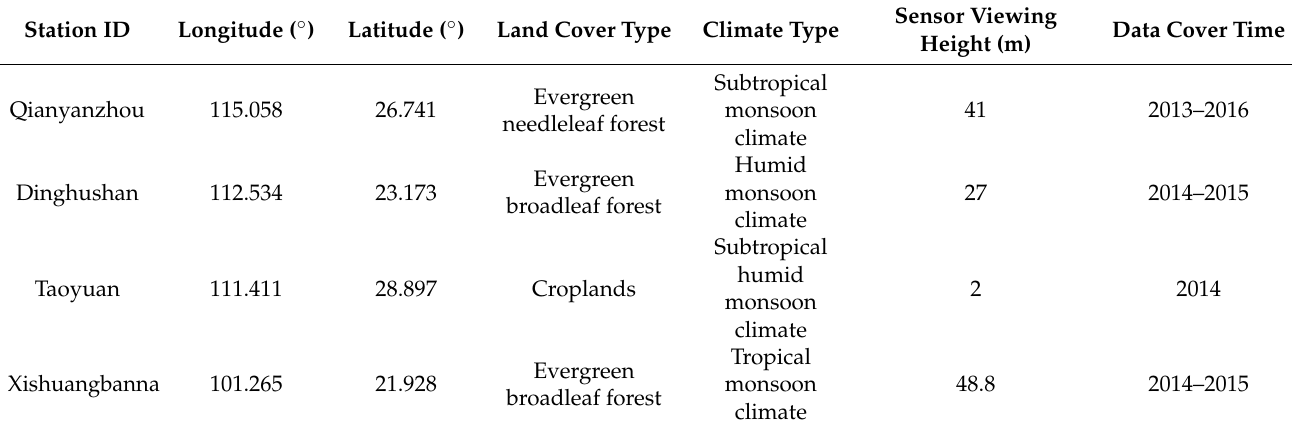
Table 1. The basic description of the four ChinaFLUX